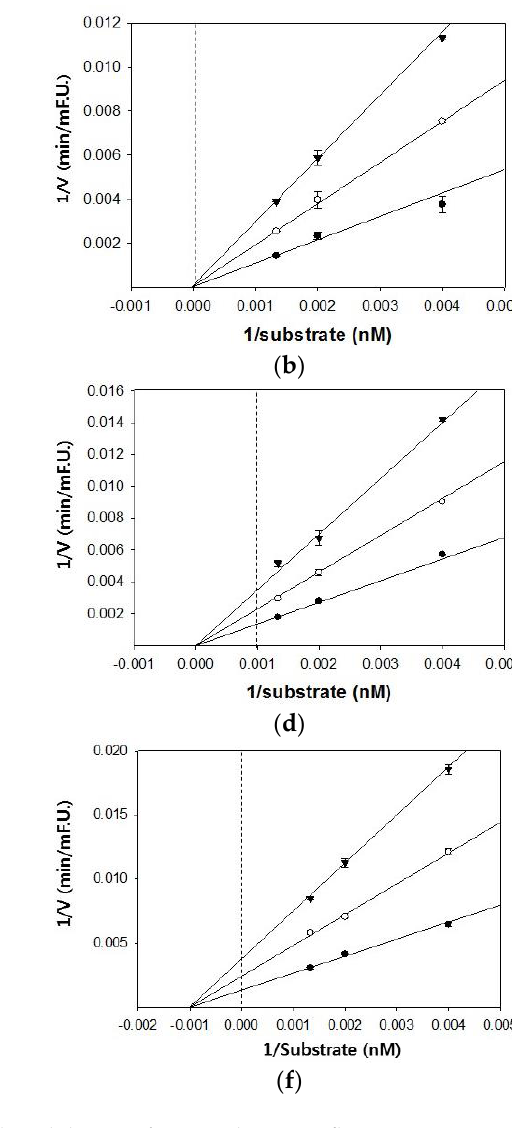
), (cid:35) ), 100 µ M ( (cid:72) ) for hesperetin (cid:35)